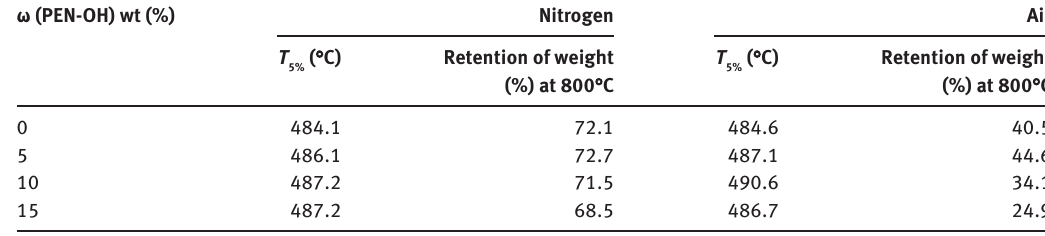
Table 2: Thermal and thermal-oxidative properties of BAPh/PEN-OH polymers with various proportions. ω (PEN-OH) wt (%)